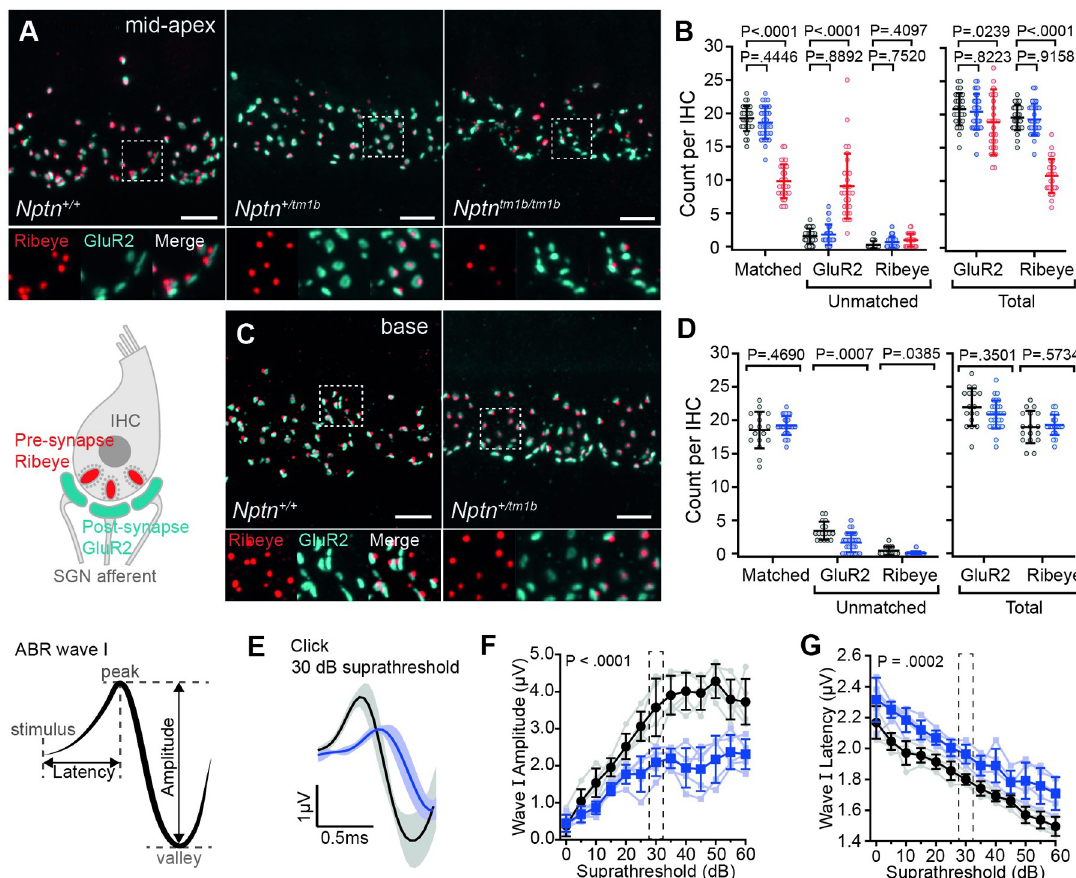
Fig 6. Heterozygous Nptn +/tm1b mice exhibit reduced ABR wave I amplitudes and increased latencies. (A) Maximum intensity projections of whole-mount mid-apical cochleae from Nptn +/+ , Nptn +/tm1b , and Nptn tm1b/tm1b mice labelled with the pre-synaptic ribbon marker Ribeye (red) and post-synaptic density marker GluR2/3 (cyan). (B) Counts of Ribeye and GluR2/3 puncta were made from ten mid-apical IHCs from Nptn +/+ (black), Nptn +/tm1b (blue) and Nptn tm1b/tm1b (red) cochleae (two independent regions per mouse, three mice per genotype). Ribeye and GluR2/3 puncta were considered matched when directly juxtaposed to one another. A larger number of unmatched GluR2/3 puncta and fewer Ribeye puncta were observed in Nptn tm1b/tm1b cochleae. (C) Maximum intensity projections of whole-mount basal cochleae from Nptn +/+ and Nptn +/tm1b mice labelled with the pre-synaptic ribbon marker Ribeye (red) and post- synaptic density marker GluR2/3 (cyan). (D) Counts of Ribeye and GluR2/3 puncta were made from 5–10 IHCs from Nptn +/+ (black) and Nptn +/tm1b (blue) cochleae (two independent regions per mouse, three mice per genotype). Nptn +/tm1b mice show a decrease in the number of unmatched GluR2/3 puncta compared with Nptn +/+ . Insets in (A) and (C) are an enlarged view of a 5 μ m x 5 μ m region highlighted by the dashed box in the corresponding above image. Scale bars in (A) and (C) = 5 μ m. Data are mean ± SD with individual data points shown. Data are compared against wild type controls using unpaired t-tests with a Holm-Sidak correction for multiple comparisons. (E) Averaged ABR wave I in response to a click stimulus recorded at 30 dB above hearing threshold for Nptn +/tm1b (blue line, n = 5) and Nptn +/+ (black line, n = 5) mice. Across all intensities, Nptn +/tm1b mice had reduced amplitudes (F) and increased latencies (G) compared with Nptn +/+ mice. Data are mean ± SD with individual data points shown. Analysed using a two-way